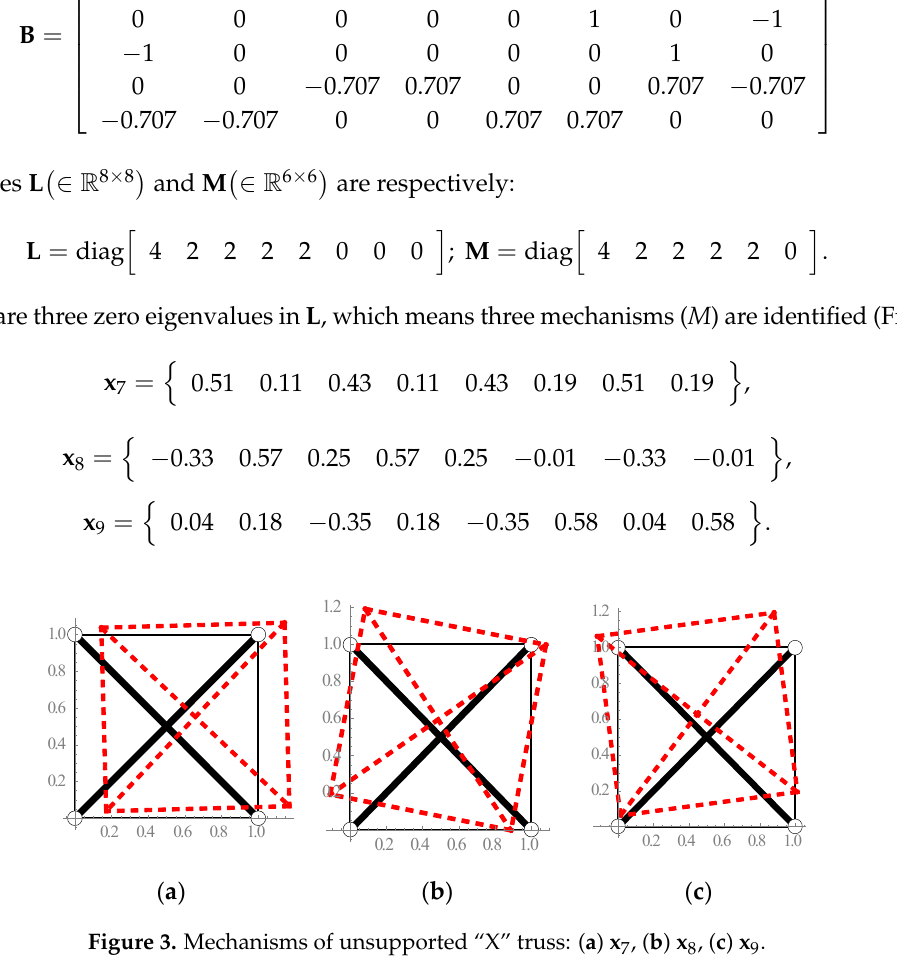
Figure 3. Mechanisms of unsupported “X” truss: ( a ) x 7 , ( b ) x 8 , ( c ) x 9